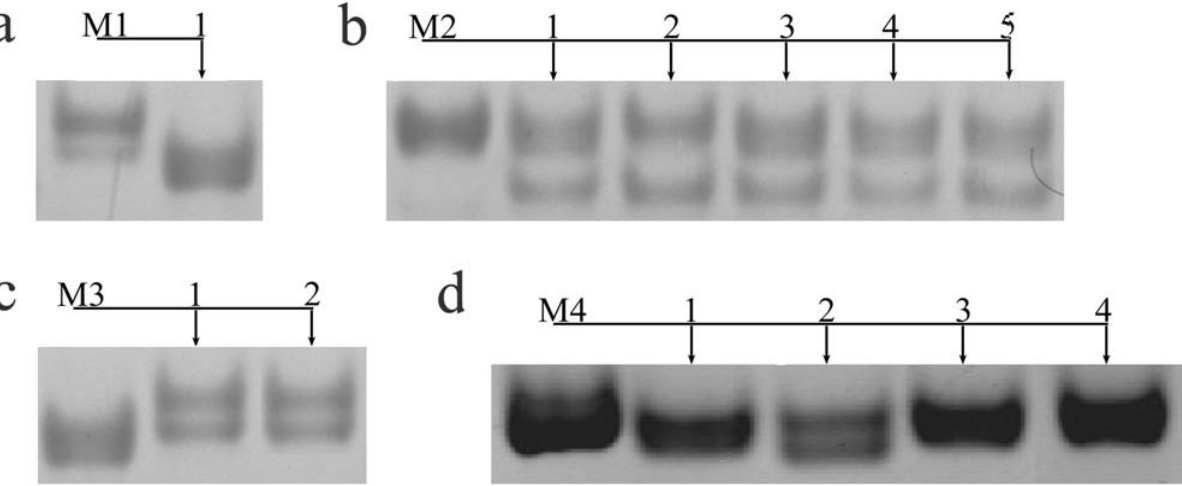
Figure 2. Intrafamily electrophoretic variability of PCR products amplified at Du281 locus of parthenogenetic lizards Darevskia unisexualis . a – family 1, b – family 2, c – family 3, d – family 4. Maternal DNAs are marked by M1–M4 respectively; offspring DNAs are shown by arrows and numbered in each family.